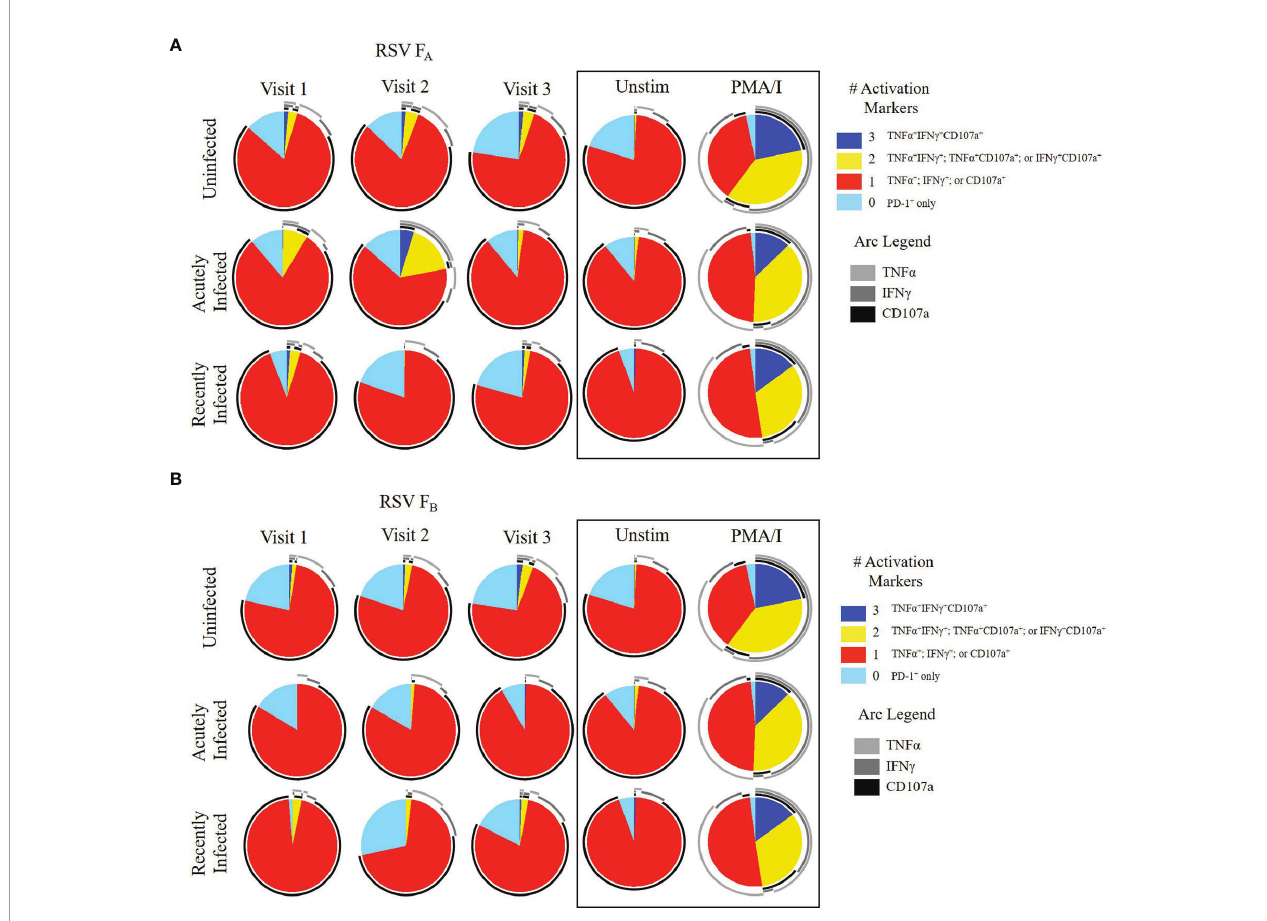
FIGURE 3 | CD8 + Memory T cell responses to RSV F protein peptide libraries as a function of RSV infection status and study visit. Polyfunctional CD8 + Memory T cell responses to (A) RSV F A or (B) RSV F B protein peptide libraries by RSV infection status: uninfected ( n = 12), acutely infected ( n = 4), and recently infected ( n = 3). Simpli fi ed Presentation of Incredibly Complex Evaluations (SPICE) analysis was performed for the identi fi cation of CD8 + memory T cells expressing multiple cytokines. Pie charts show the frequency in which PBMCs produced the various combinations of the activation markers CD107a, IFN g , and TNF a ; or expressed PD-1 alone. Background (determined from the media-stimulated negative controls) was subtracted from all samples and negative values were set to zero. Surrounding arcs denote the speci fi c markers produced by the cells in each pie segment. Representative negative and positive controls across all study visits are